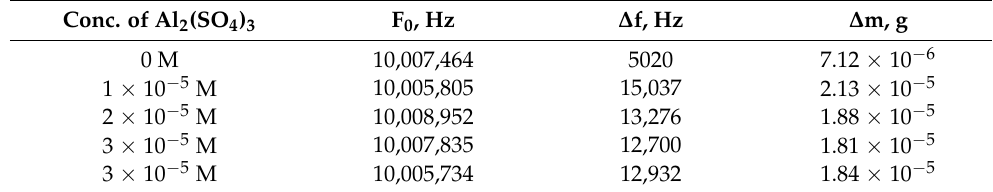
Table 3. Calculated mass ( ∆ m) of the electrochemical ZnO:Al layers deposited on the larger electrode of the quartz